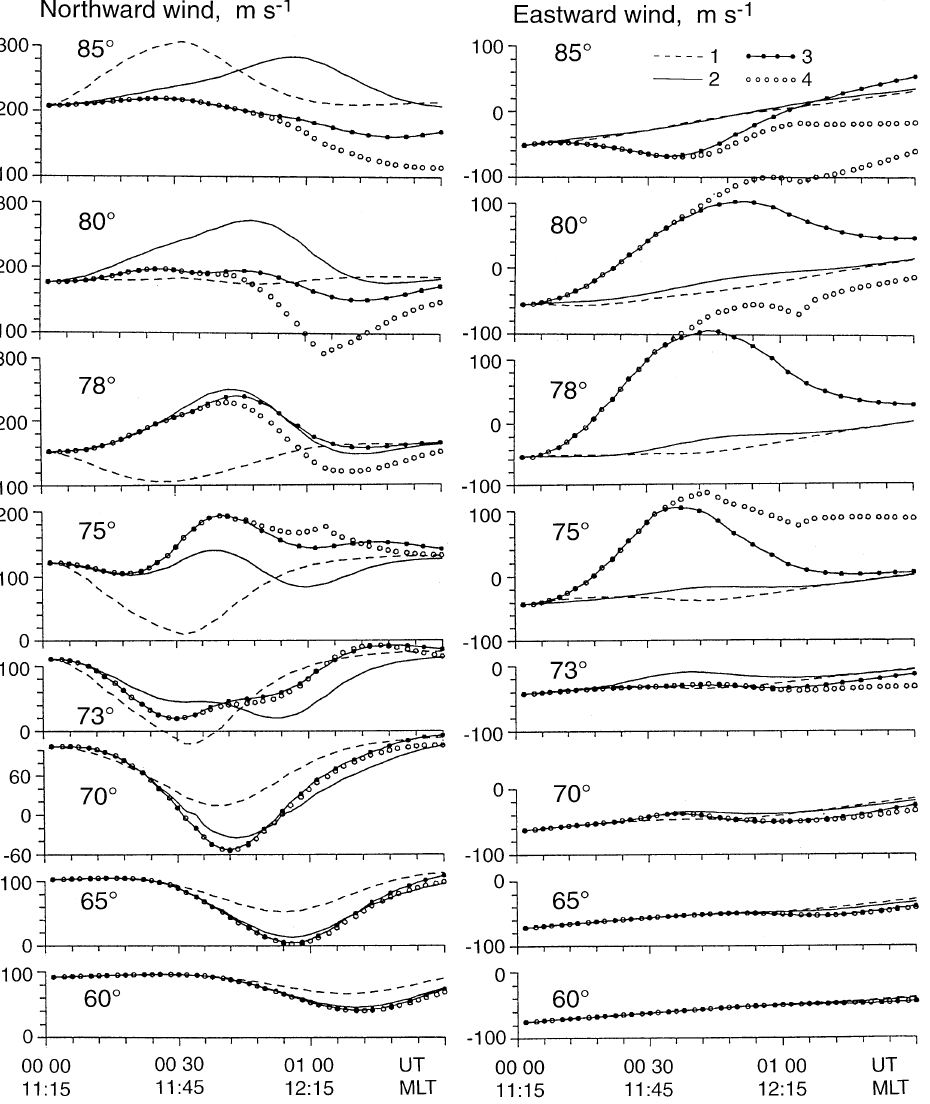
Fig. 7. The same as in Fig. 5 but for the meridional, positive northward ( left - hand plots ) and zonal, positive eastward ( right - hand plots ) thermospheric wind